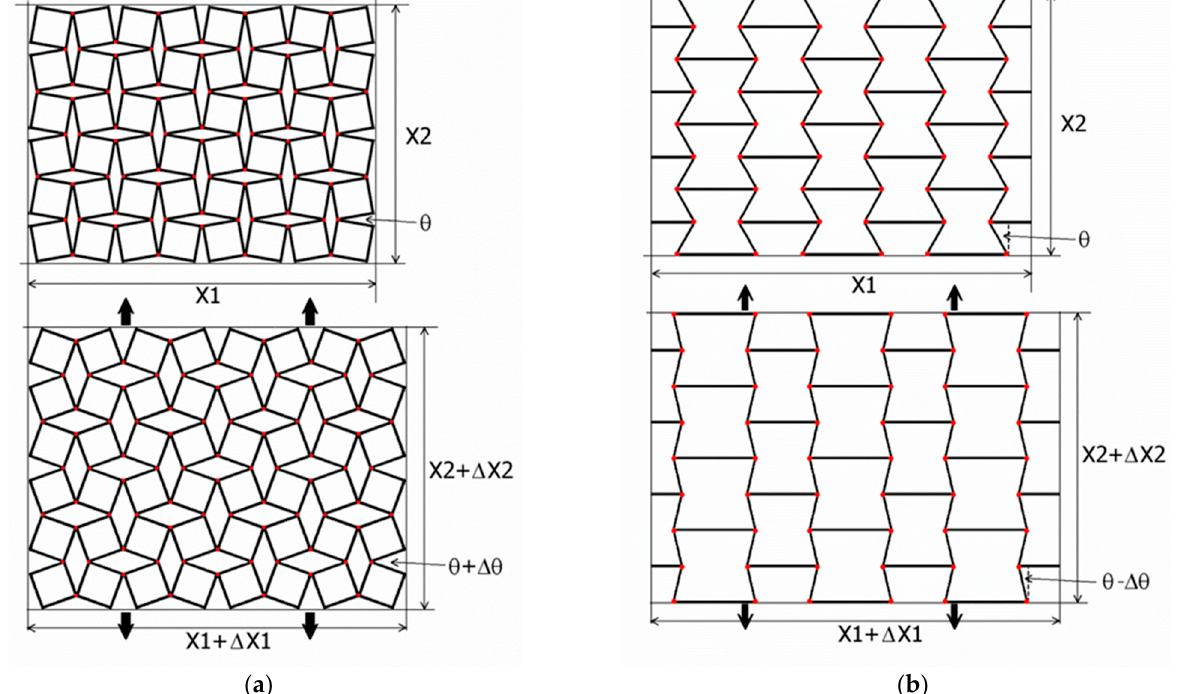
Figure 2. Models of auxetic structures built from unit cells in the form of rigid squares ( a ) and re- entrant—‘bow tie’ cells ( b ) with hinges marked by red dots. re-entrant—‘bow tie’ cells ( b ) with hinges marked by red